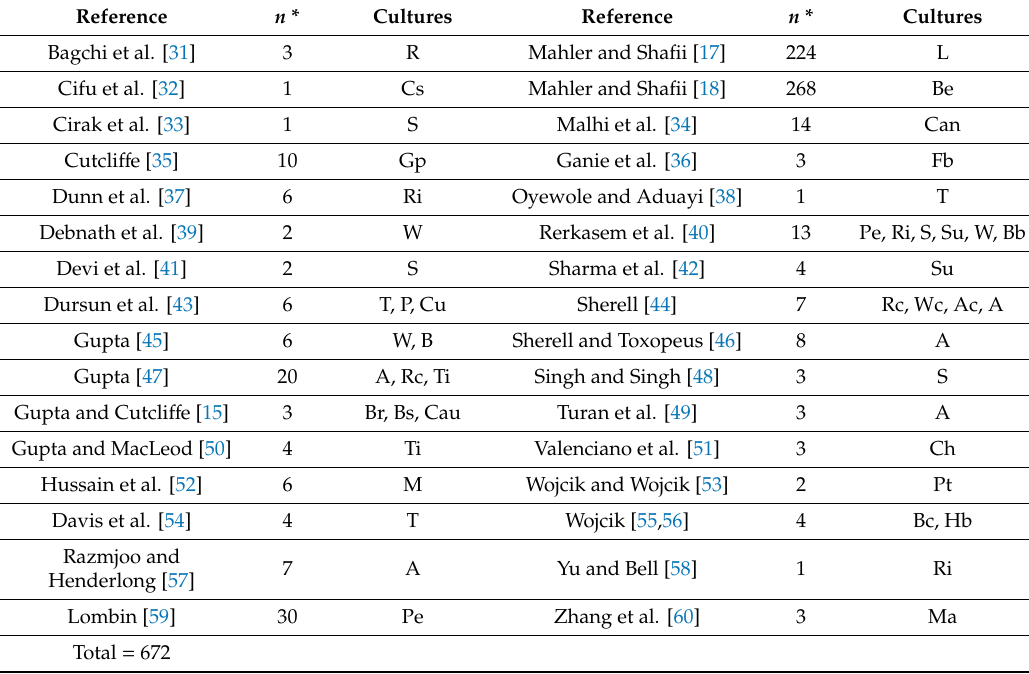
Table 2. Literature data for the boron agronomic model (Data base